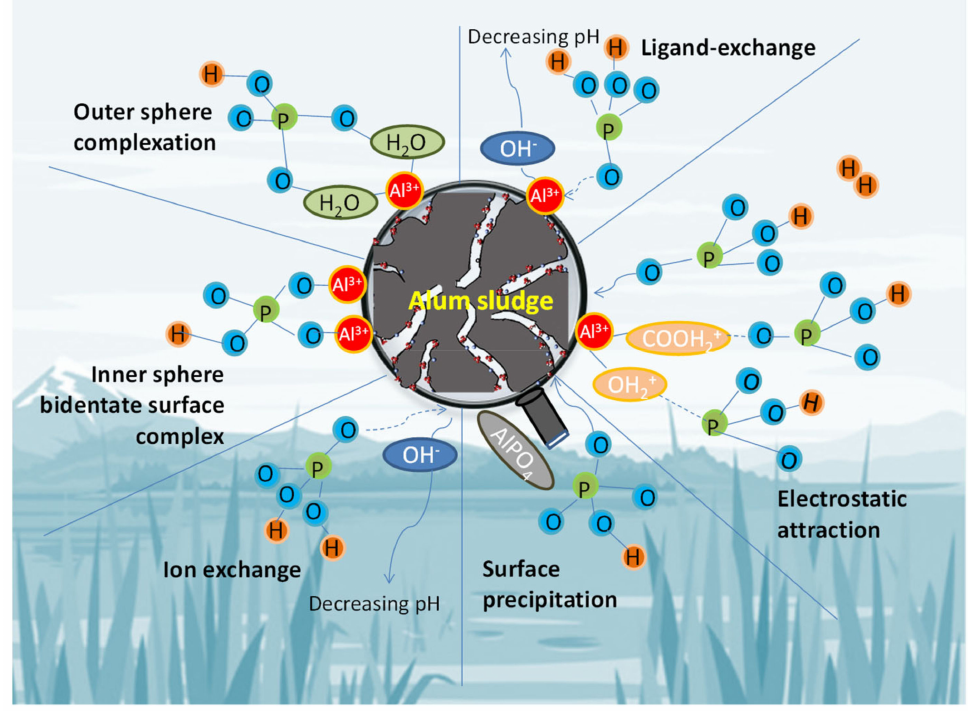
Figure 4. Schematic overview of potential P adsorption mechanisms by AlS